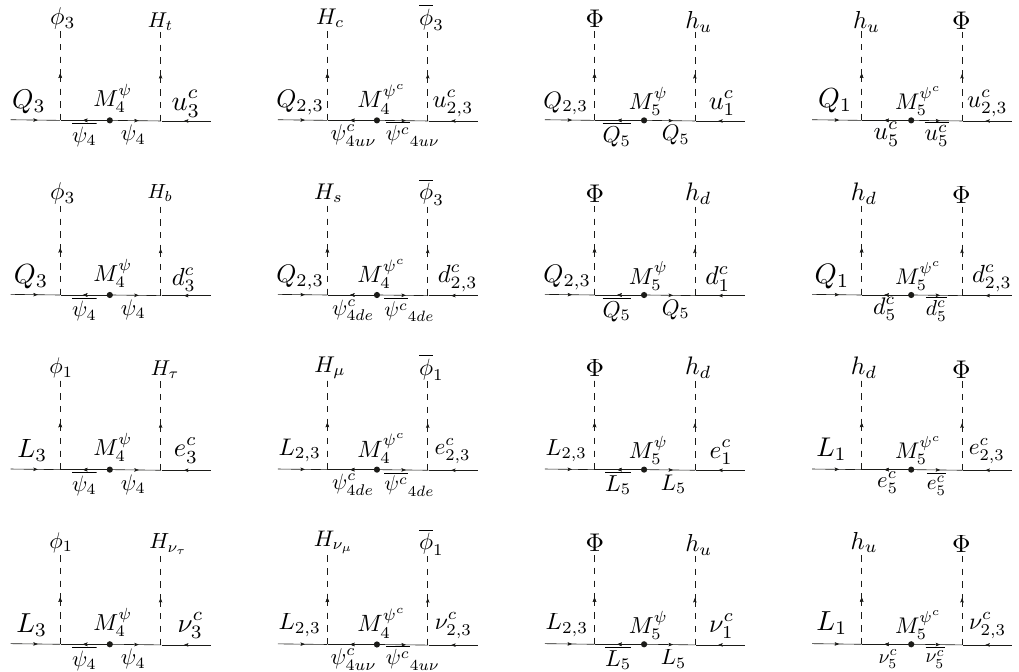
Figure 4 . Diagrams which yield the mass matrices for all quarks and leptons in the low energy G 4321 theory, arising from the decomposition of figures 2, 3. The couplings respect G 4321 according to the assignments in table 3. Each row of diagrams represents a particular charged fermion, u, d, e, ν , generating the effective mass matrices in eqs. (3.13), (3.14), (3.15), (3.16), respectively, The columns of diagrams generate the entries in the mass matrix proportional to A, B, C, D , respectively. Note the 8 independent personal Higgs fields H in the first two columns of diagrams, associated t , . . . , H ν µ with the 3rd and 2nd